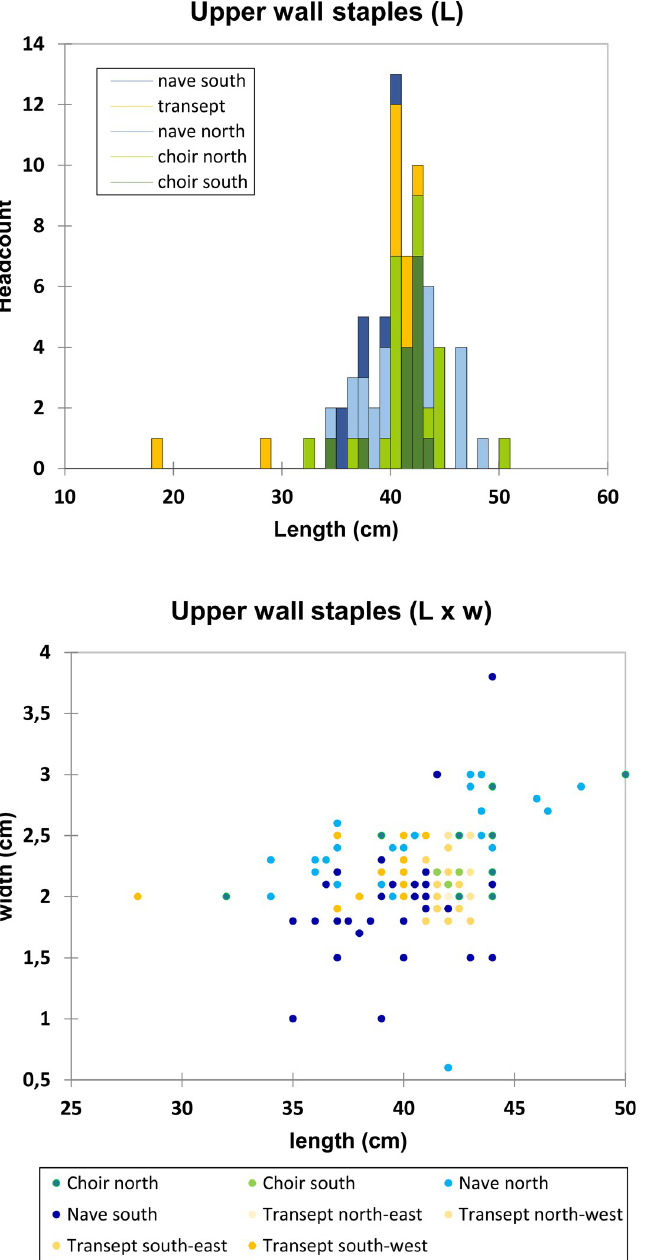
Fig 9. Dimensions of the staples of the upper